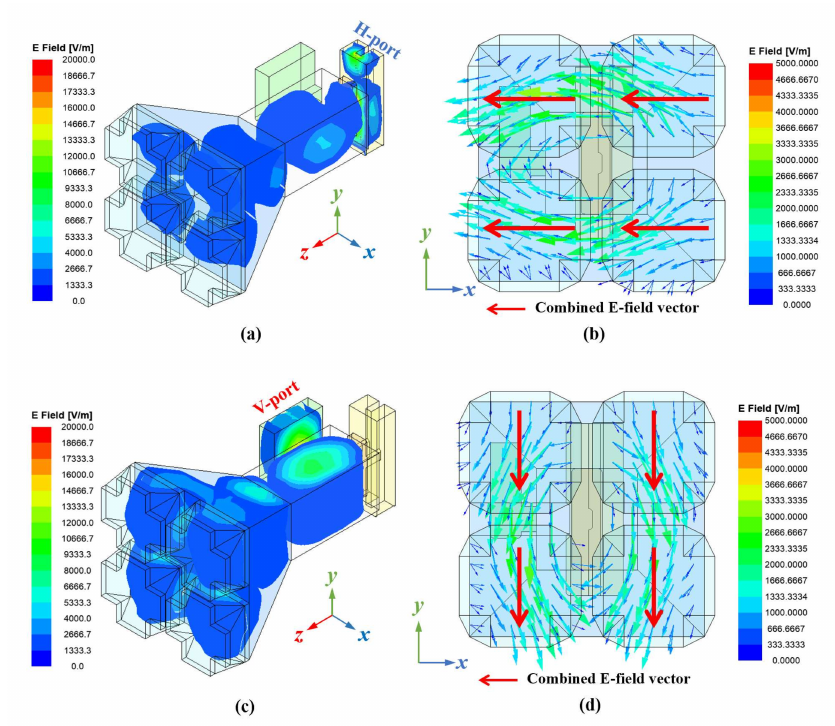
Figure 4. E-field distribution of the dual-polarization 2 × 2-unit ME-dipole subarray: ( a , b ) H-pol; ( c , d )